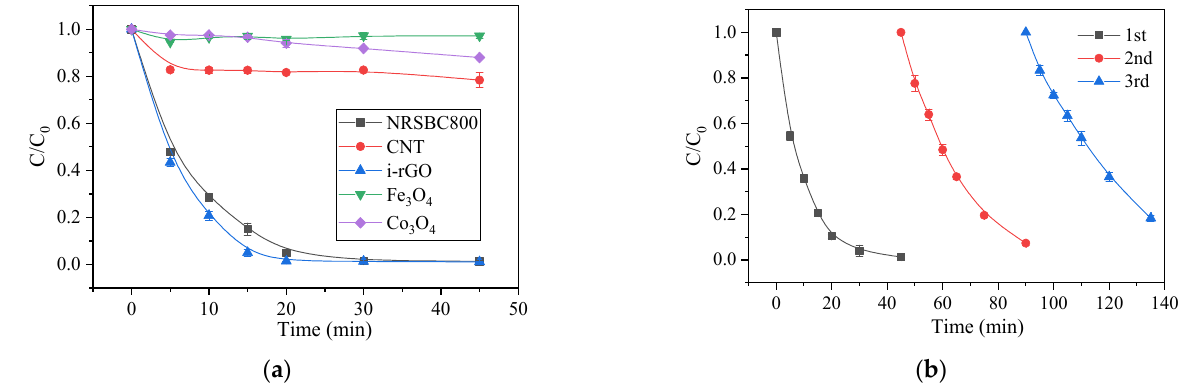
Figure 6. ( a ) Catalytic performances of different materials for PMS activation on AO7 removal; ( b ) degradation of the AO7 using the recycled NRSBC800. Condition: [AO7] = 50 mg/L, [catalyst] = 100 mg/L, [PMS] = 614 mg/L and T = 25 °C.